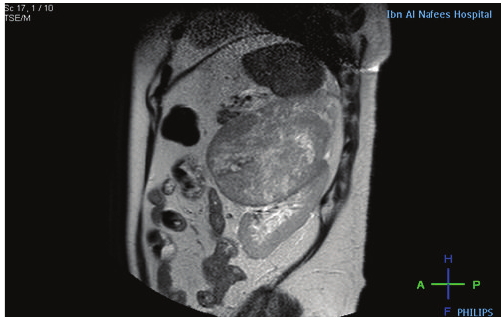
Figure 2: Sagittal T2W image: the lesion shows intermediate signal with multiple small hyper intense areas due to necrosis.